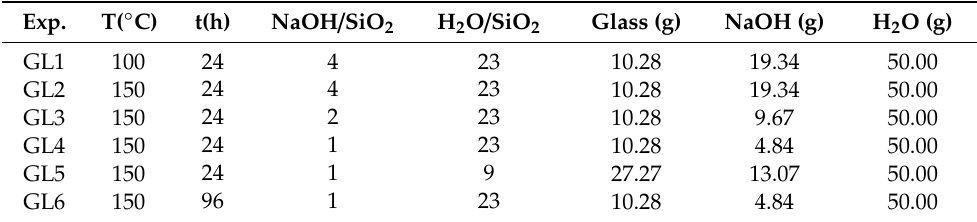
Table 4. Experiments on waste glass